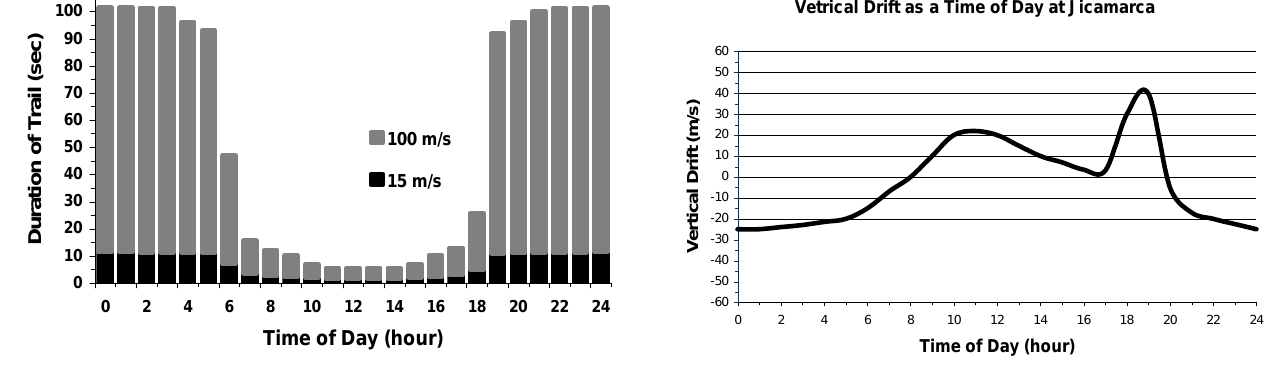
Fig. 6. Average vertical drift speed model over Jicamarca obtained from Fejer and Scherliess (2001). This data is used to drive the Figure 6. Average vertical drift speed model over Jicamarca obtained from [Fejer and Scherliess, 2001]. meteor simulations as a function of time. The vertical drift data This data is used to drive the meteor simulations as a function of time. The vertical drift data was was multiplied by nominal cowling and geometrical factor of 10 in multiplied by nominal cowling and geometrical factor of 10 in order to approximate the drift speed order to approximate the drift speed perpendicular to both B and perpendicular to both B and the meteor trail. When drift speeds are approach zero the model predicts no the meteor trail. When drift speeds are approach zero the model long duration trails are produced. predicts no long duration trails are